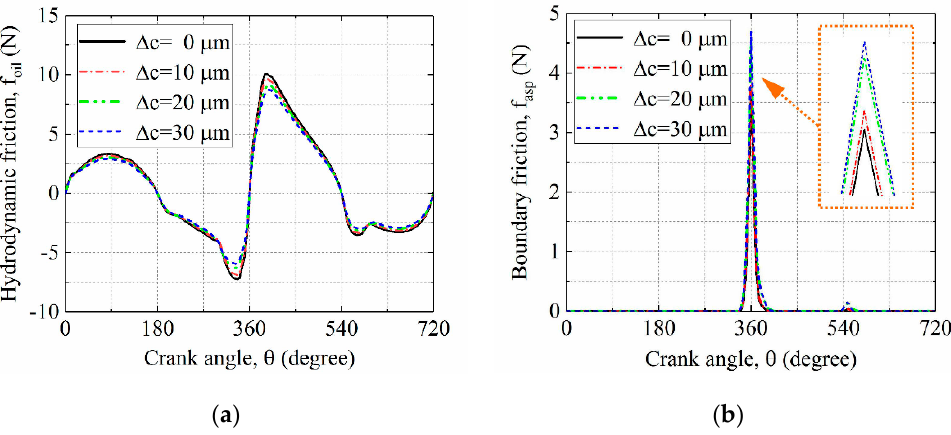
Figure 8. Friction forces in the groove textured RLC for different maximum deformations of liner: ( a ) Hydrodynamic friction force; ( b ) boundary friction force.